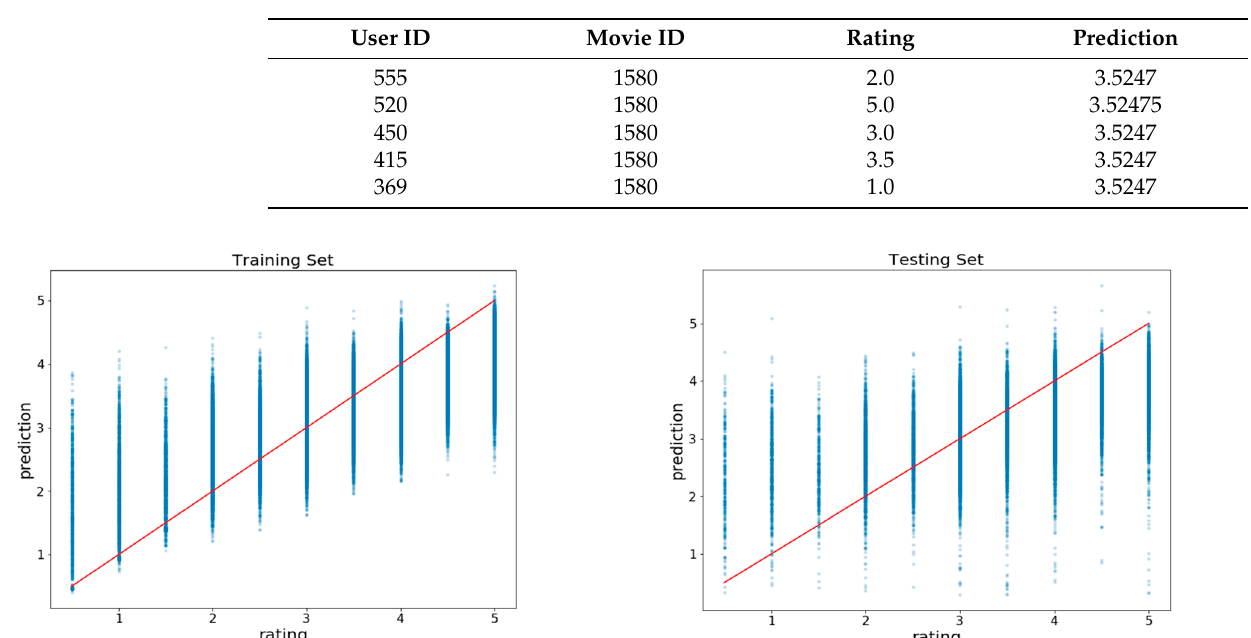
Figure 8. Graphical representation of training and testing set predictions.